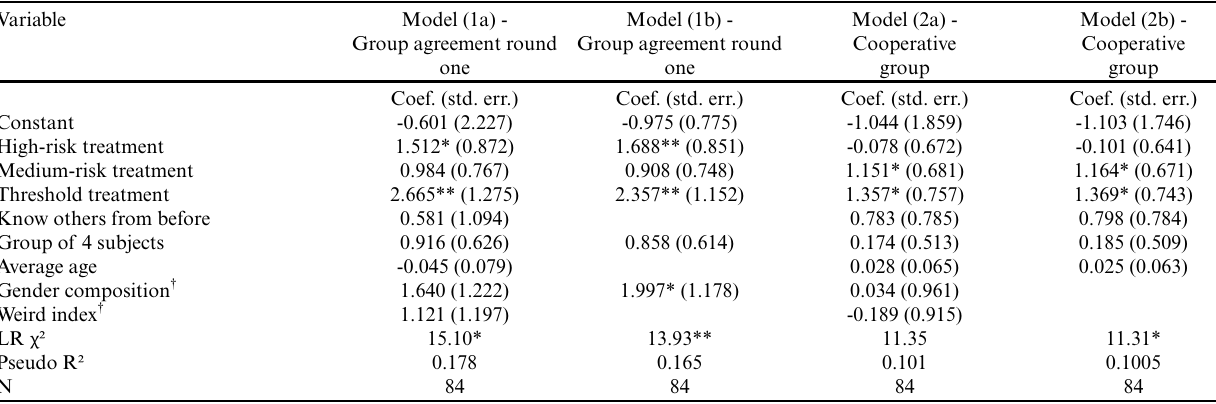
Table 5 . Logistic regression results of group agreement in round one and cooperative group. Variable